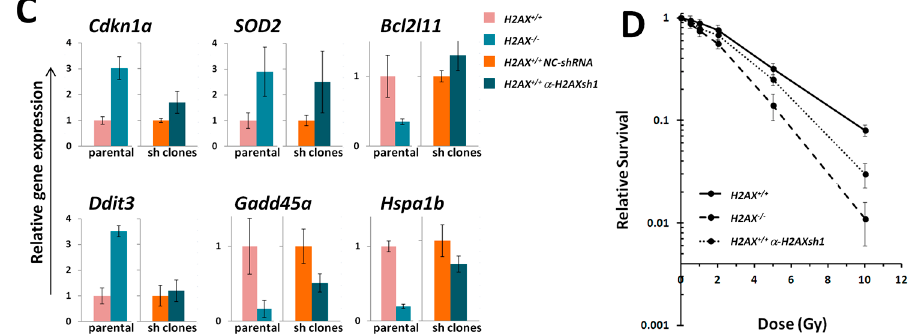
Figure 6. FoxO3a transcriptional activity reporter assay and H2AX knockdown experiments support involvement of H2AX in FoxO3a-mediated gene expression and radiosensitivity. ( A ) Luciferase activity in H2AX + / + and H2AX − / − cells stably expressing luciferase reporter gene under the control of FoxO3a-responsive promoter. The H2AX + / + luc-1 clone and the H2AX − / − luc-1 clone, alone with negative controls (NC), were exposed to 5 Gy γ -radiation or left untreated. Cells were lysed 1 h after irradiation and luciferase activity was measured. ** and *** denote statistically significant difference with p < 0.01 and 0.001, respectively (Student’s t -test) from three experiments; ( B ) Western blot image showing H2AX protein levels in parental H2AX + / + and H2AX − / − cells and in four clones of H2AX + / + cells stably expressing shRNA targeting H2AX, along with a negative control (NC); ( C ) Effect of H2AX knockdown on the basal expression of six genes found to be differentially expressed in H2AX + / + and H2AX − / − cells (see Figure 3). NC denotes cells expressing non-targeting shRNA (sh); ( D ) Effect of H2AX knockdown on the clonogenic survival of MEF cell lines. Data represent the mean ± SD obtained from two independent experiments (three technical replicates in each experiment).